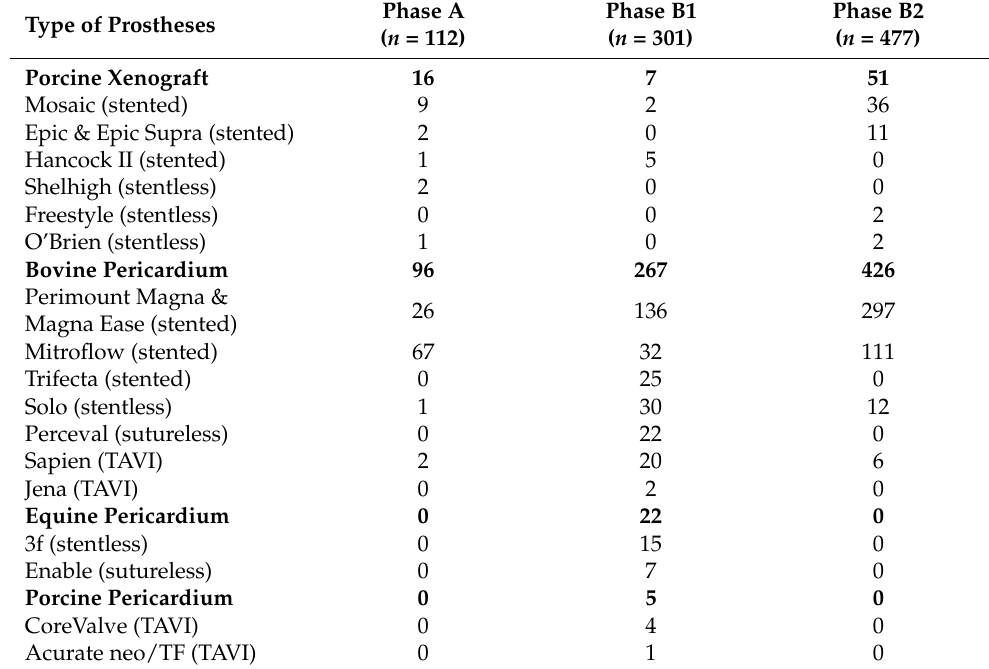
Table 2. Types of biological prostheses implanted.